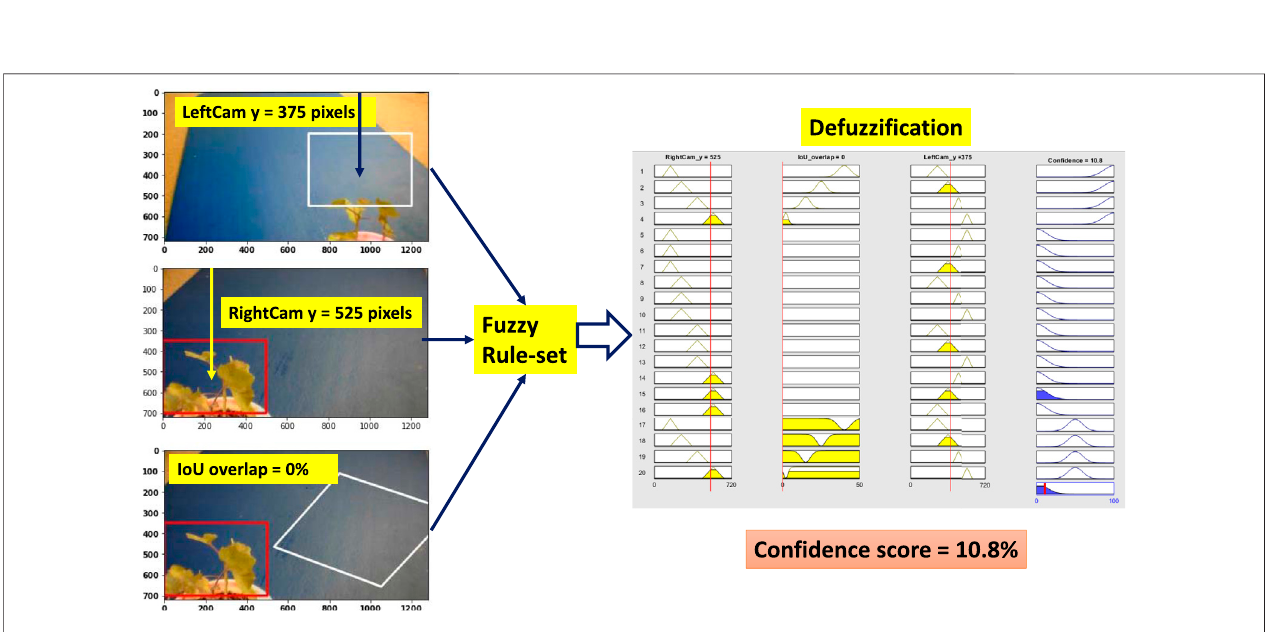
FIGURE 11 | Fuzzy con fi dence score measurement (low con fi dence).